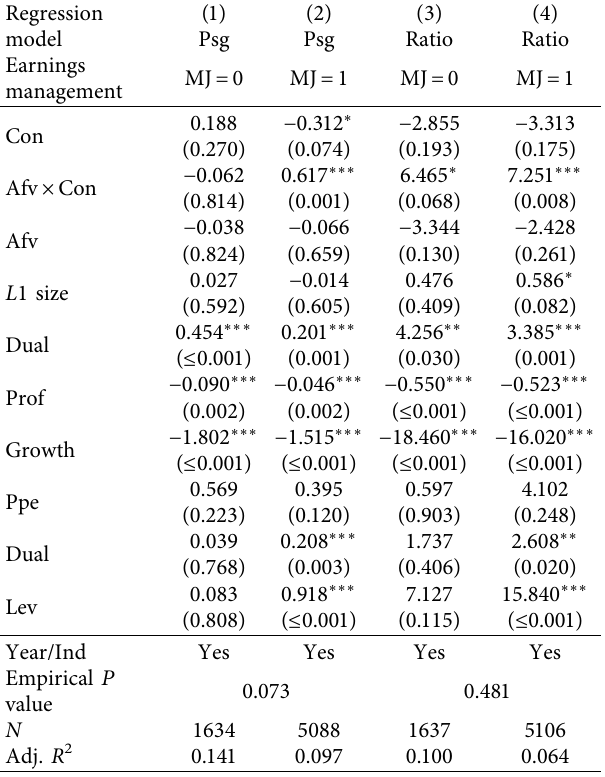
Table 6: The influence of earnings management on the adjustment of fair value